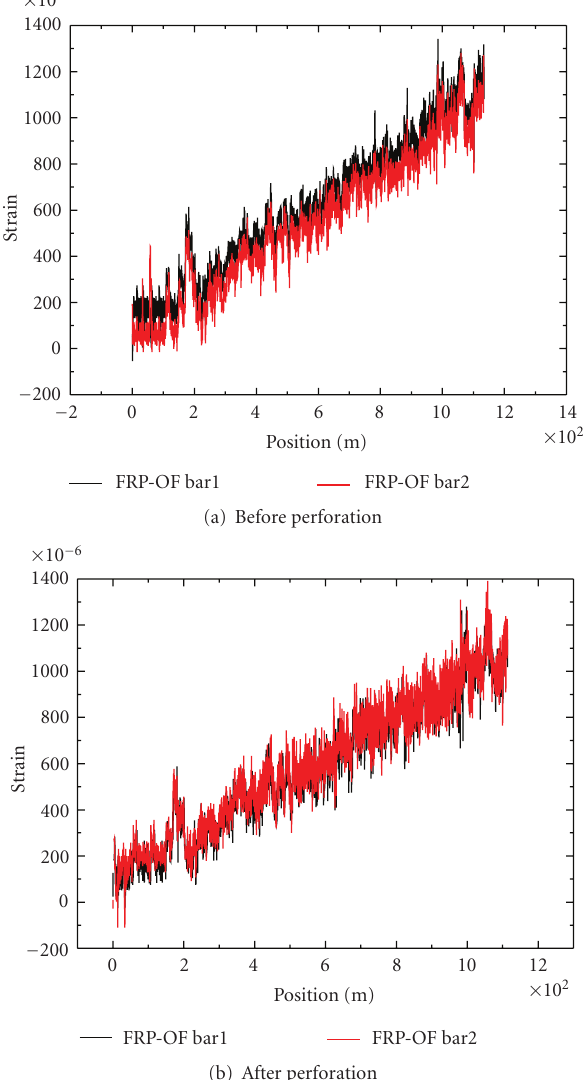
Figure 17: Strain distribution from the